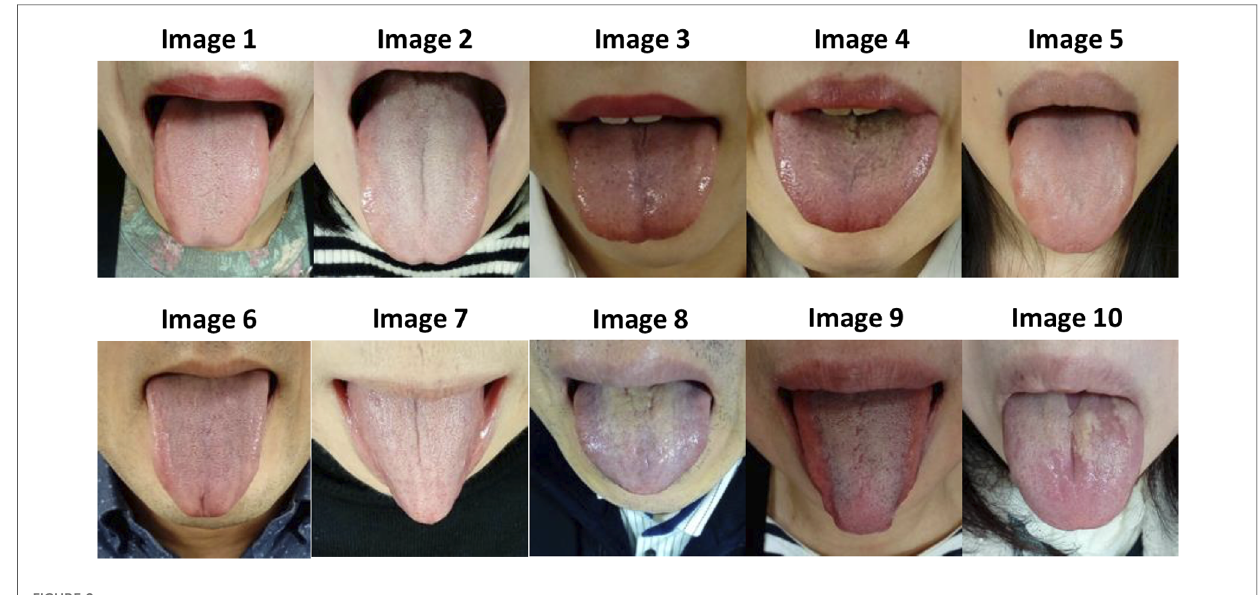
FIGURE 2 Tongue images of the tongue diagnosis test. (Study 1).